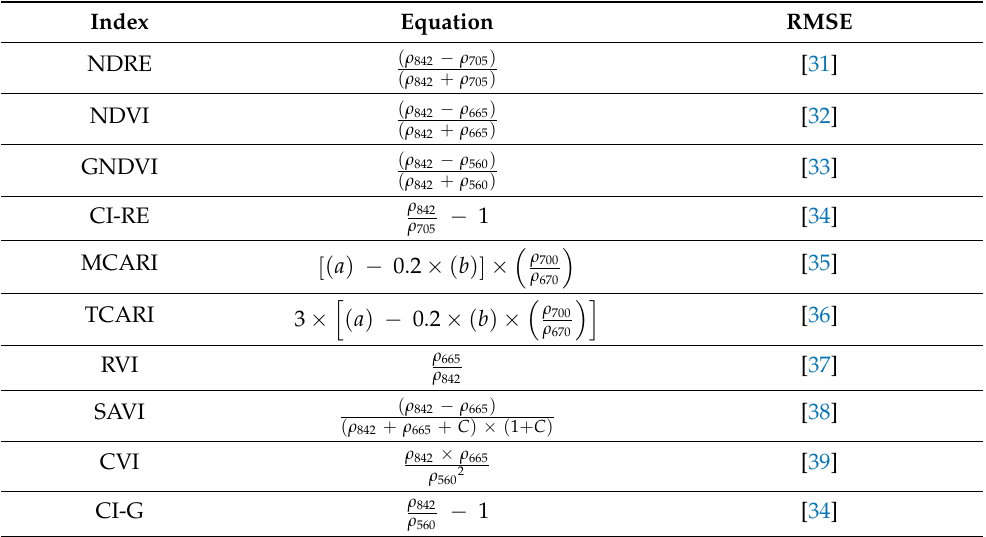
NDVI: normalized difference vegetation index; GNDVI: green normalized difference vegetation index; CI-RE: chlorophyll index—red edge; MCARI: modified chlorophyll absorption in reflectance index, where a = R 700 − R 670